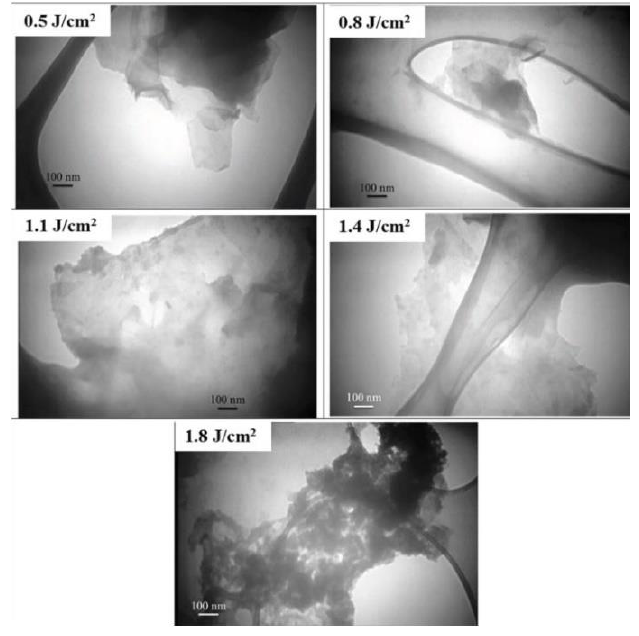
Figure 21. The effect of laser fluence on the formation of GNS [86].